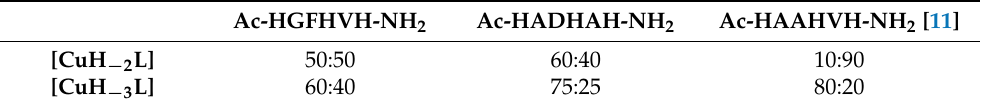
Figure 6. Comparison of experimental CD spectra of the [CuH − 3 L] complex of Ac-HADH-NH 2 (blue), Ac-HVH-NH 2 (orange) [5] and Ac-HADHAH-NH 2 (red) with superposition of CD spectra of [CuH − 3 L] of Ac-HADH-NH 2 and Ac-HVH-NH 2 in 75:25% (black). Table 3. The estimated ratio of –HXZH- coordinated and –HXH- coordinated species of three-histidine-containing hexapeptides .